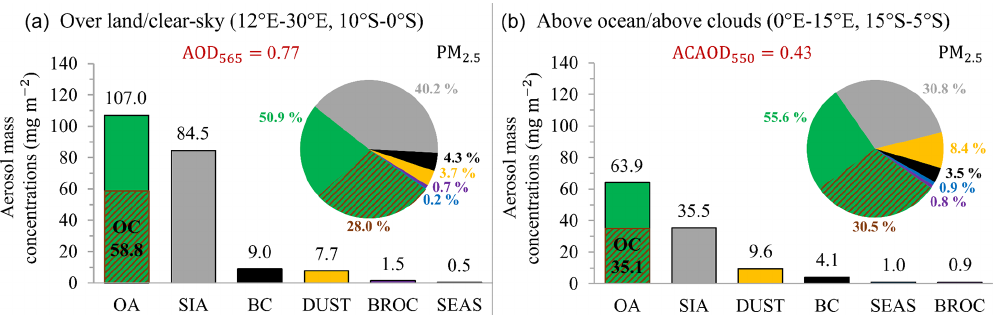
Figure 15. Evolution of the PM 2 . 5 chemical composition simulated with the WRF-Chem optimized configuration between the southern African continent in clear sky (12–30 ◦ E, 10–0 ◦ S, a ) and the southeastern Atlantic Ocean above clouds (0–15 ◦ E, 15–5 ◦ S, b ). Mass con- centrations (in mgm − 2 ) of the main aerosol compounds of biomass burning, i.e. black carbon (BC, in black), organic carbon (OC, in brown hatching), brown carbon (BrOC, in purple), organic aerosols (OA, in green), and secondary inorganic aerosols (SIA, in grey), as well as desert dust aerosols (DUST, in yellow) and sea salt aerosols (SEAS, in blue), are vertically integrated over the atmospheric column on average for the first half of July 2008.